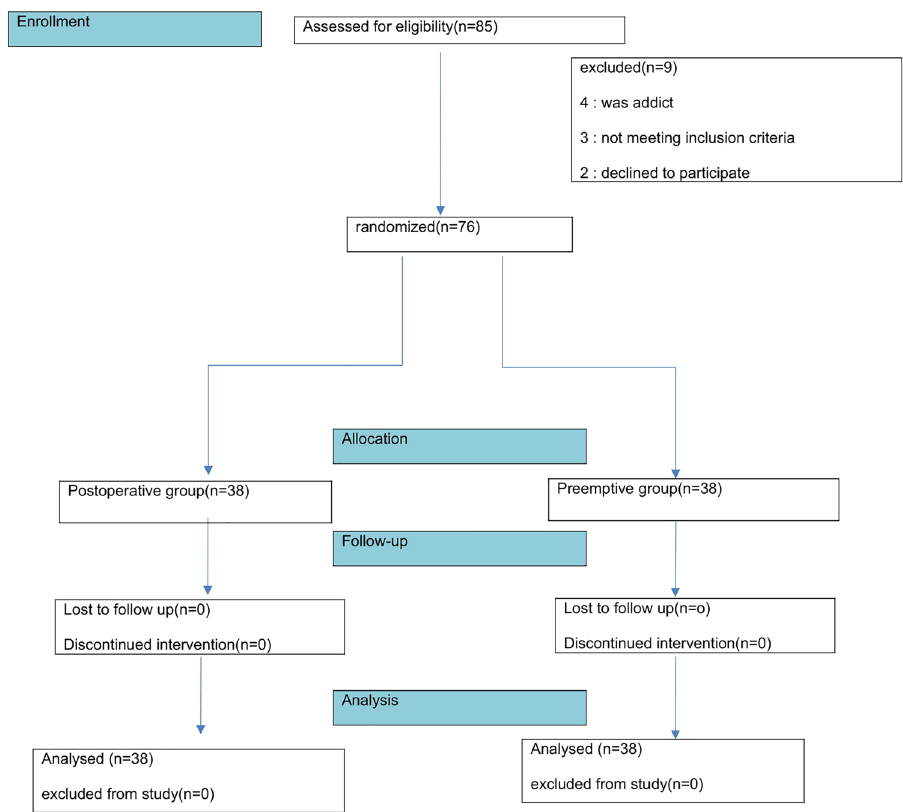
Figure 1. Flow chart of the study.